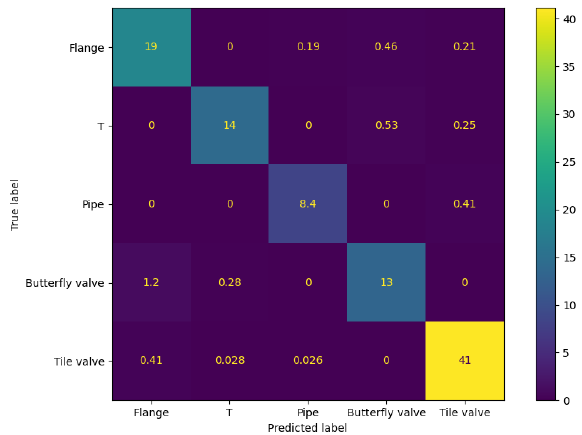
Figure 10: Normalized confusion matrix on 3D point cloud, each box corresponds to a percentage of the total data (3D